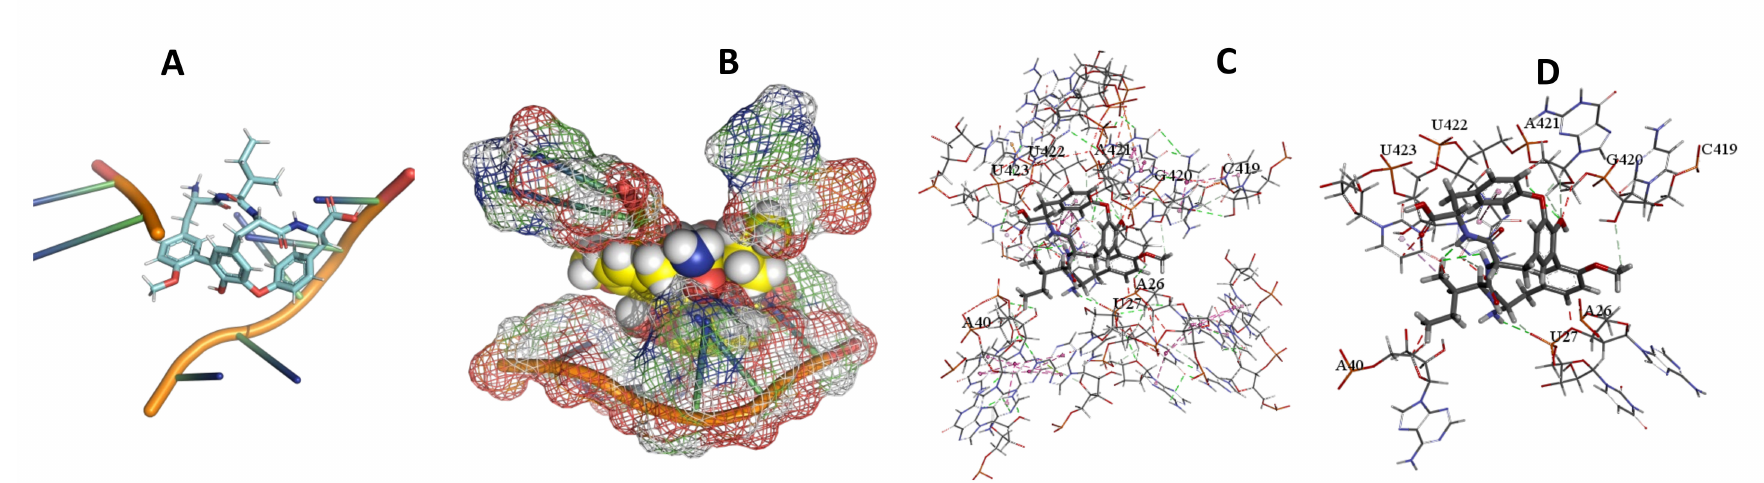
Figure 18. L. major + cittilin. ( A ): Best binding pose and nucleotides involved. ( B ): Schematic binding pocket. ( C ): shows the Nucleotides component that re involved in binding. ( D ): Shows the main bonds involved between the compound and the nucleotide component.